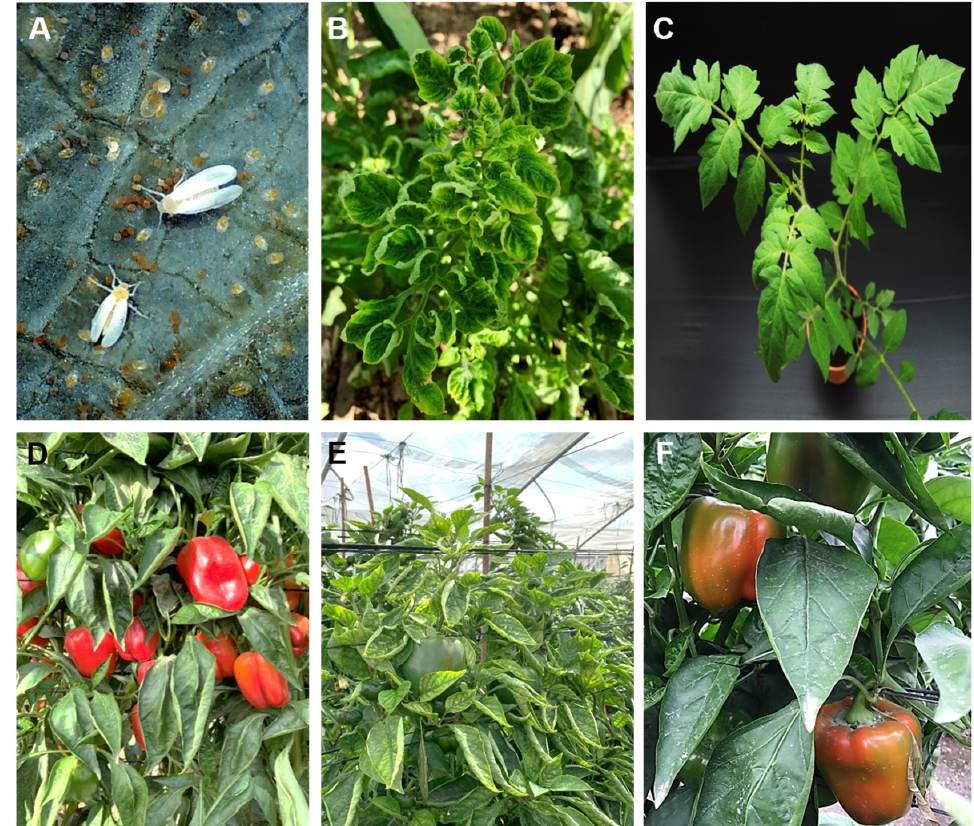
Figure 1. The two pathosystems compared in this study. The whitefly Bemisia tabaci ( A ) is the vector for the Tomato yellow leaf curl virus (TYLCV), which shows typical symptoms of yellowing and leaf curling ( B ) compared to a healthy plant ( C ). The whitefly is also a vector for Pepper whitefly-borne vein yellows virus (PeWBVYV), which shows typical symptoms of leaf curling and yellowing ( E ) and fruit discoloration ( F ) compared to uninfected plants ( D